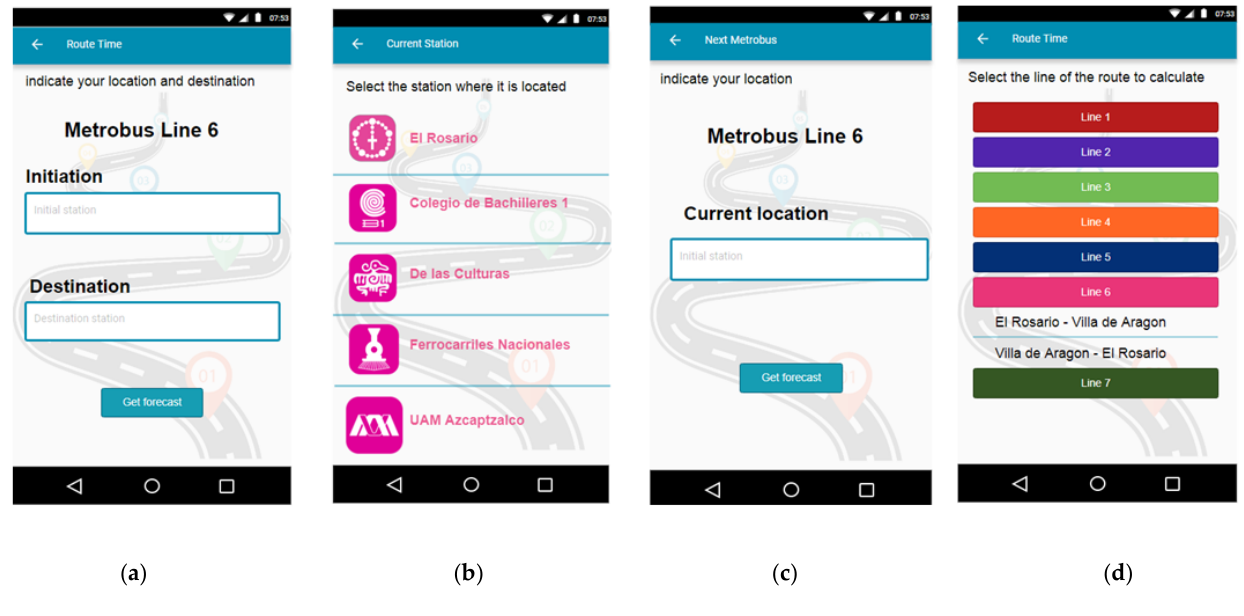
Figure 5. Main screen for presenting information: ( a ) arrival forecast selection screen, ( b ) location selection screen, ( c ) current station display, and ( d ) obtained forecast display screen.